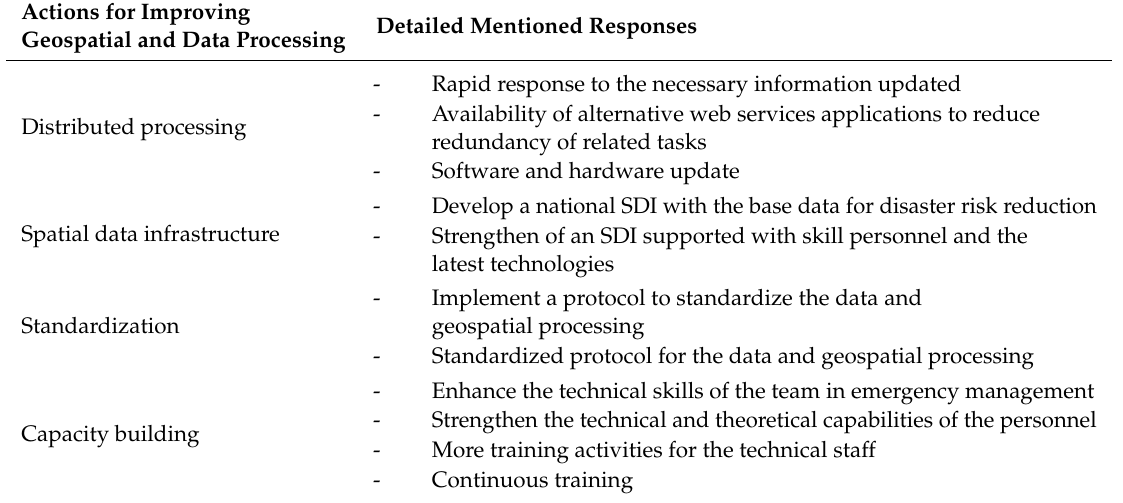
Table 5. Recommend actions for EIGEO geospatial and data processing (c) (Q30).